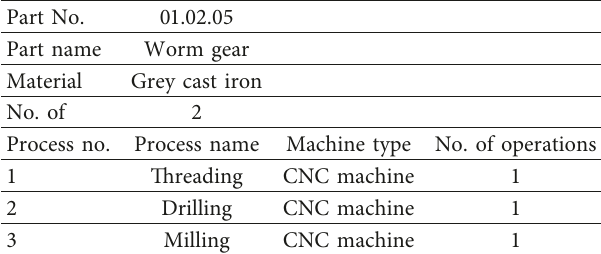
Table 18: Cover of motors.